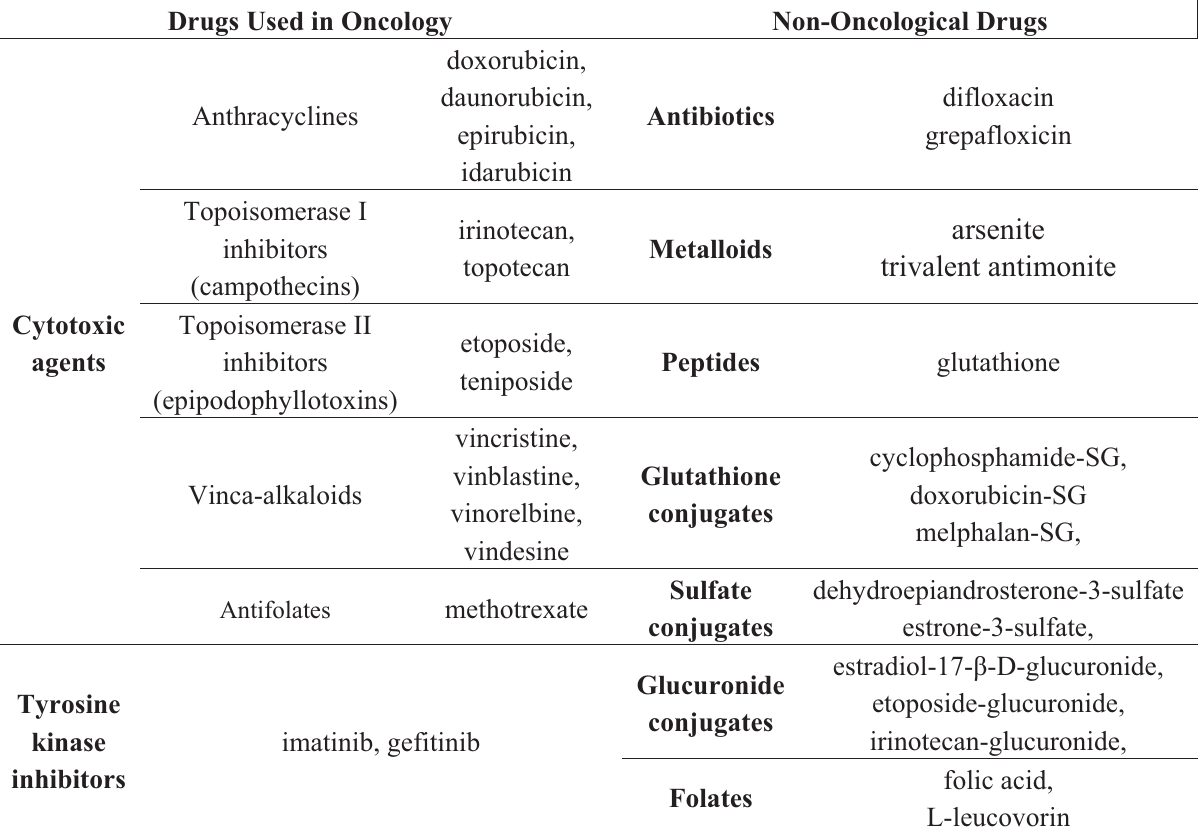
Table 6. A selection of clinically relevant drugs and compounds that are known Multidrug Resistance Protein 1 (MRP1)-substrates